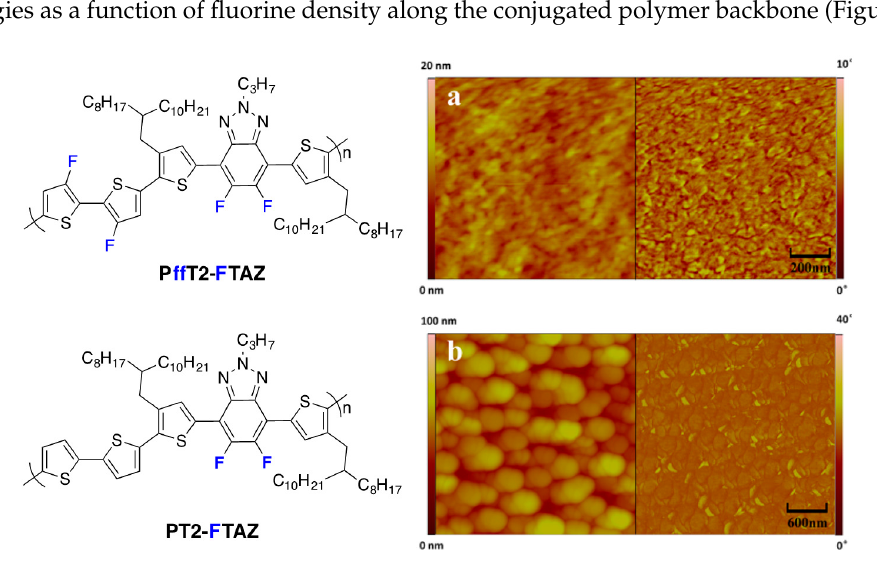
Figure 18. Chemical structures of the investigated polymers ( left ) and AFM image of PffT2-FTAZ/PC 71 BM blend ( a ) and PT2-FTAZ/PC 71 BM blend ( b ). The AFM surface topography and phase images are displayed on the left and on the right, respectively (Adapted with permission from [32]. Copyright 2015 Elsevier).